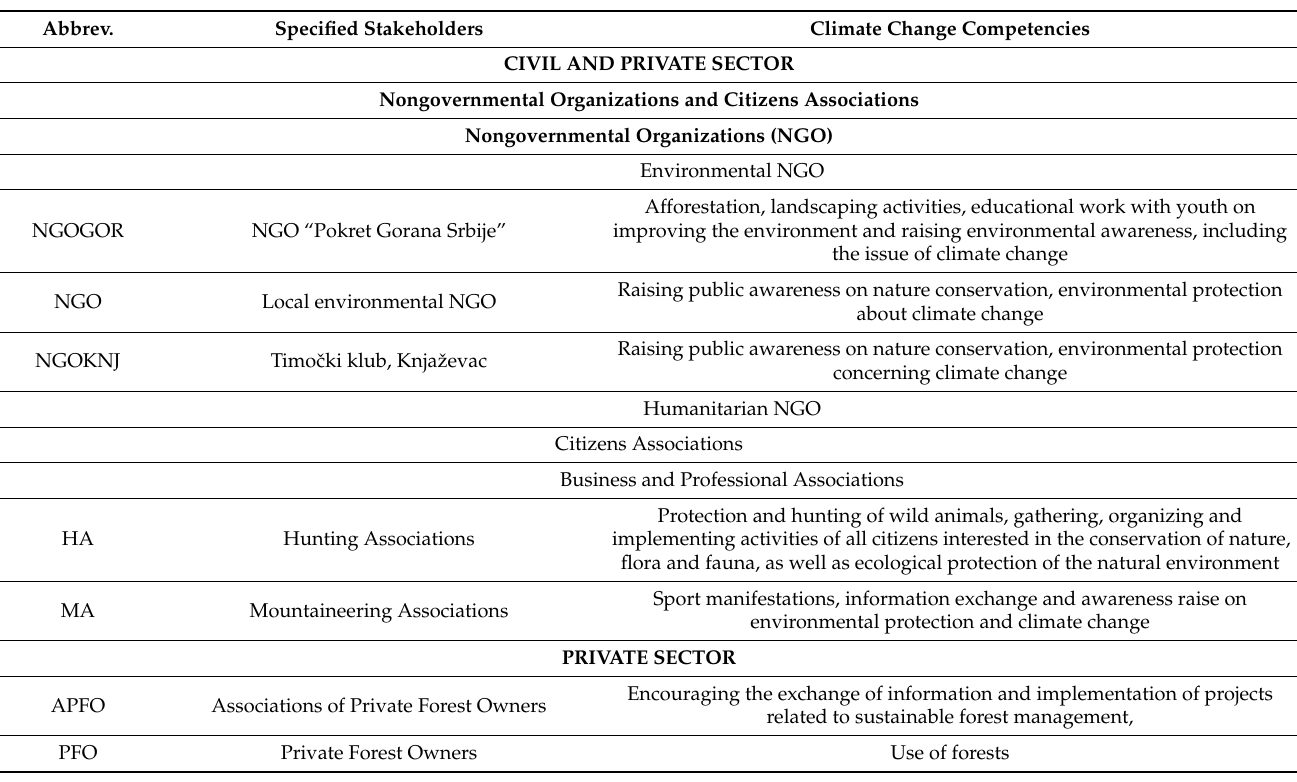
Table A2. Specified civil and private sector organizations in forestry and nature conservation with climate change competency overview.